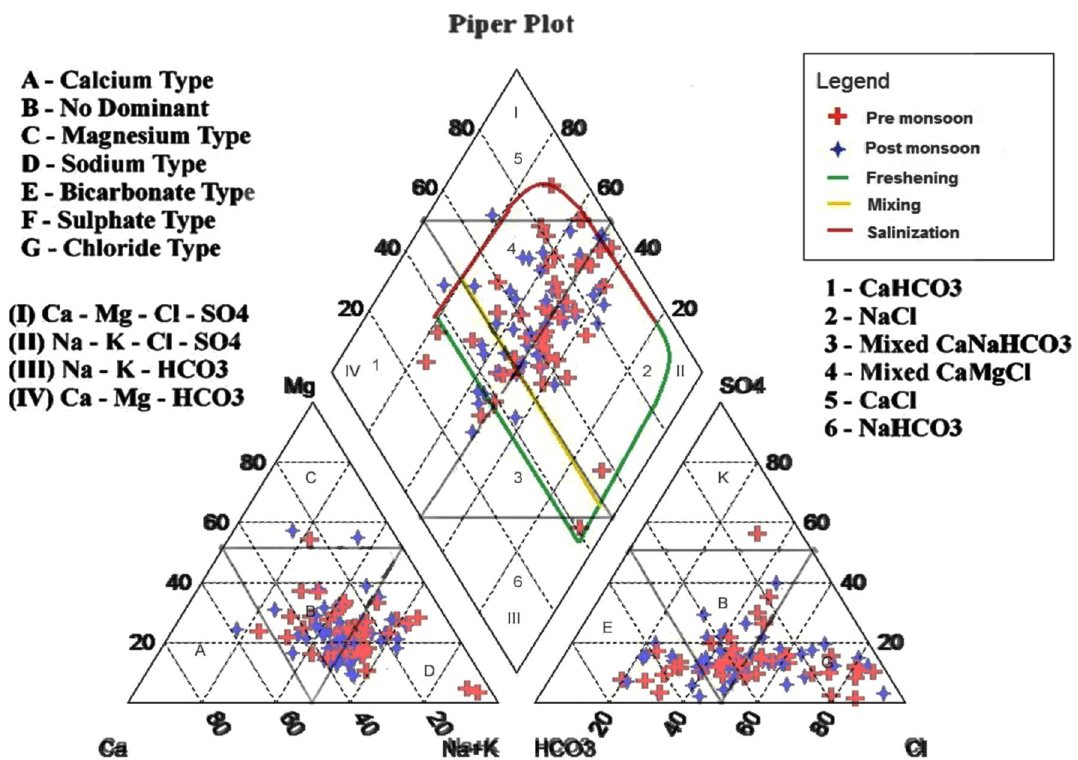
Fig. 3 Piper classification for groundwater